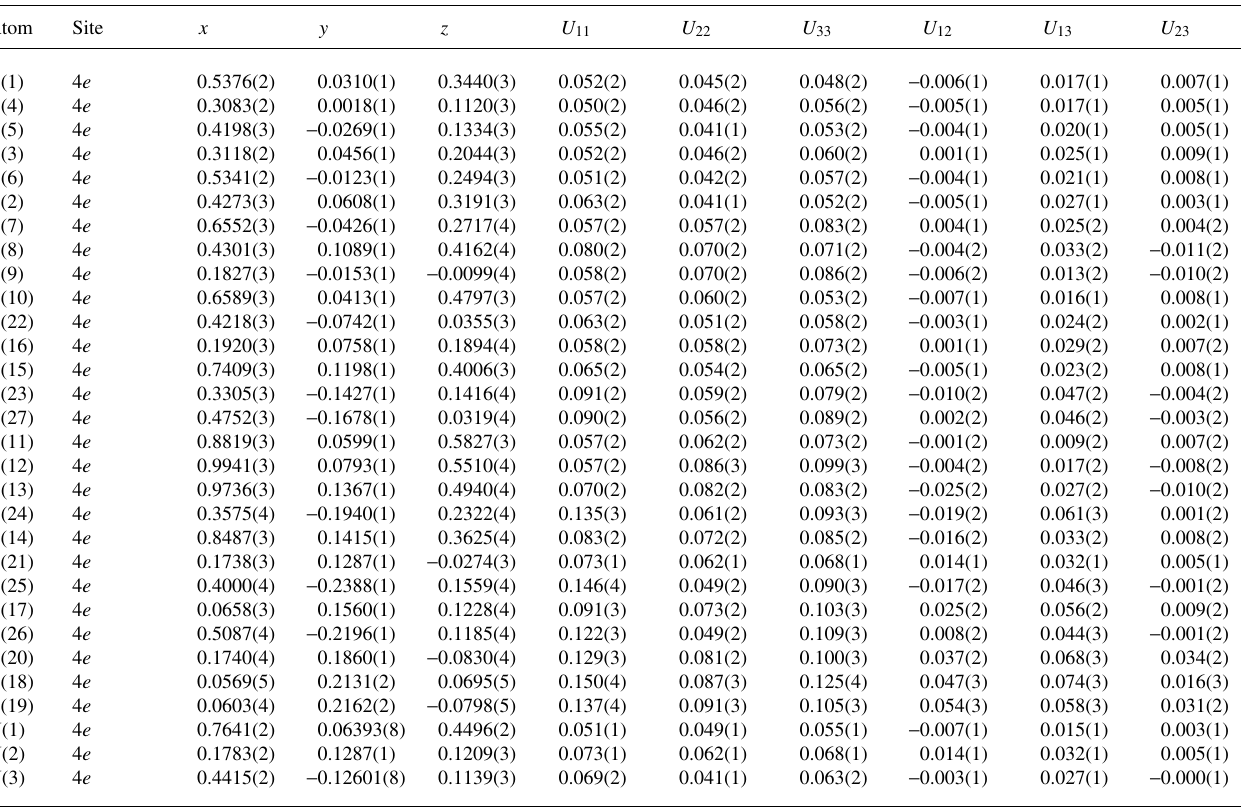
Table 3. Atomic coordinates and displacement parameters (in Å 2 )